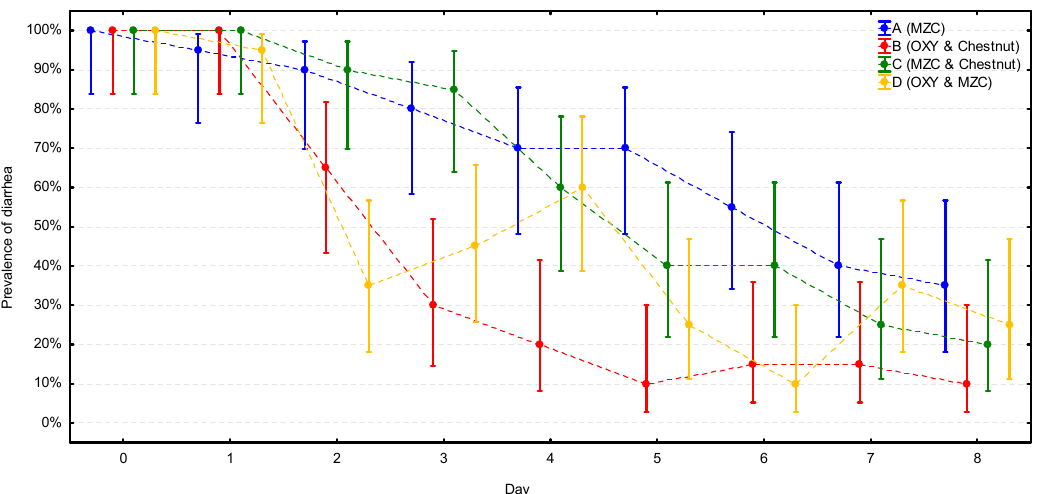
Figure2. Thechangeoftheprevalenceofdiarrhea(withCI95%)duringtheobservationperiodinthefour Figure 2. The change of the prevalence of diarrhea (with CI 95%) during the observation period in the groups ( n = 20 calves per group). MZC—micronized zeolite clinoptilolite, OXY—oxytetracycline.